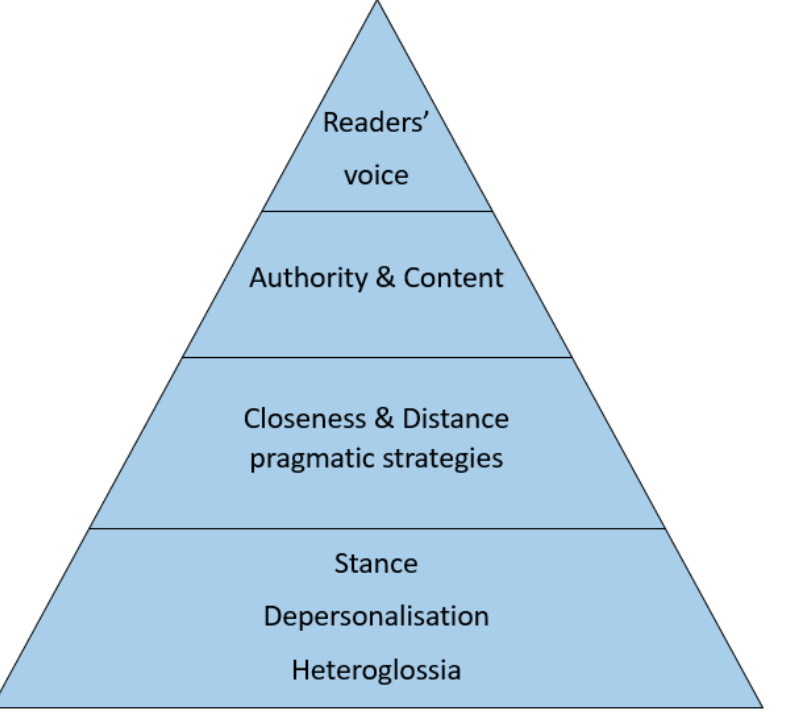
Figure 1. Readers’ authorial self-construction through closeness and distance pragmatic strategies.